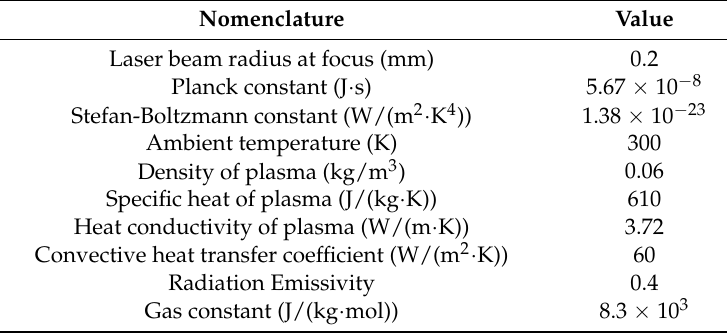
Table 4. Data used in the simulation.